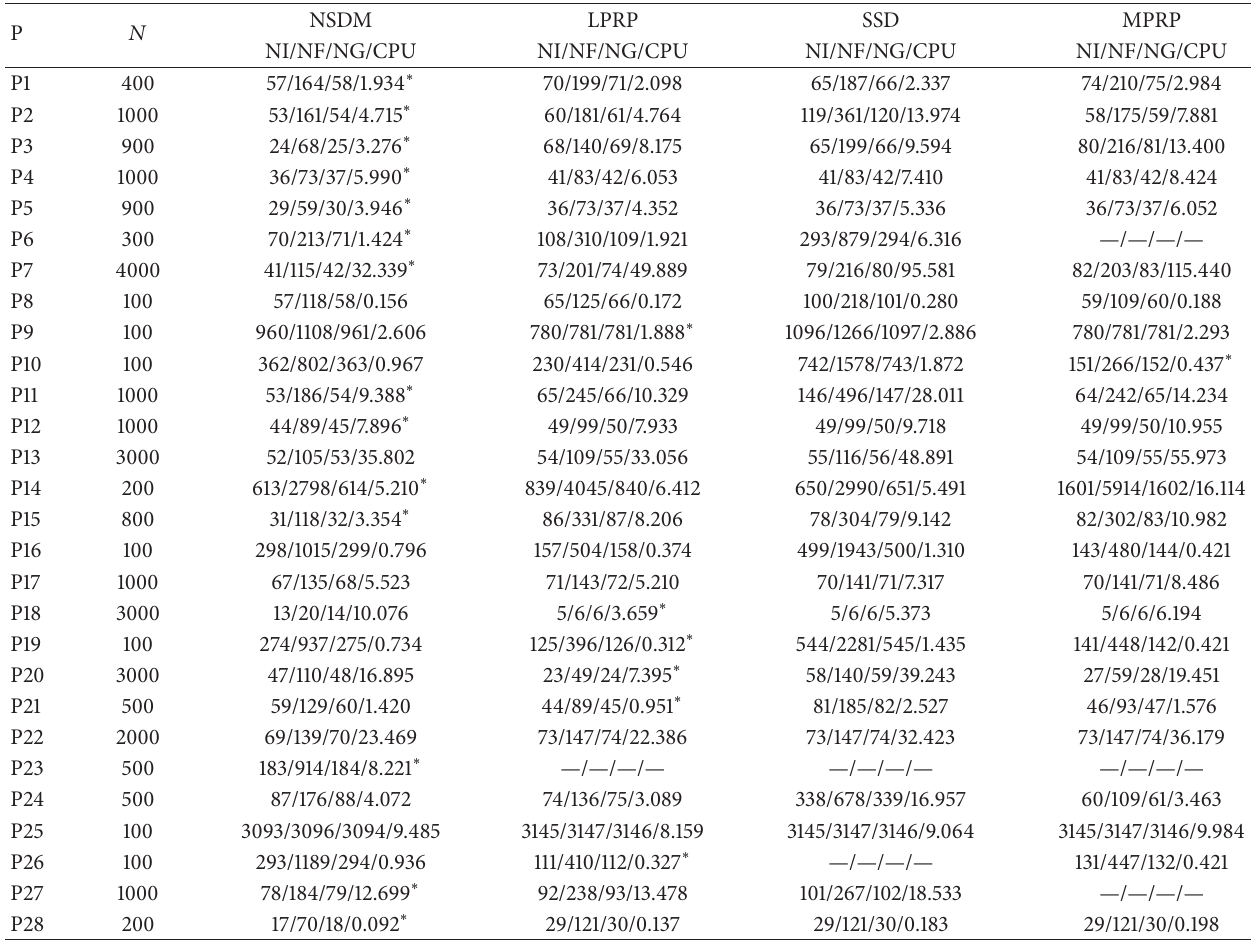
Table 2: The numerical results of the NSDM/LPRP/SSD/MPRP